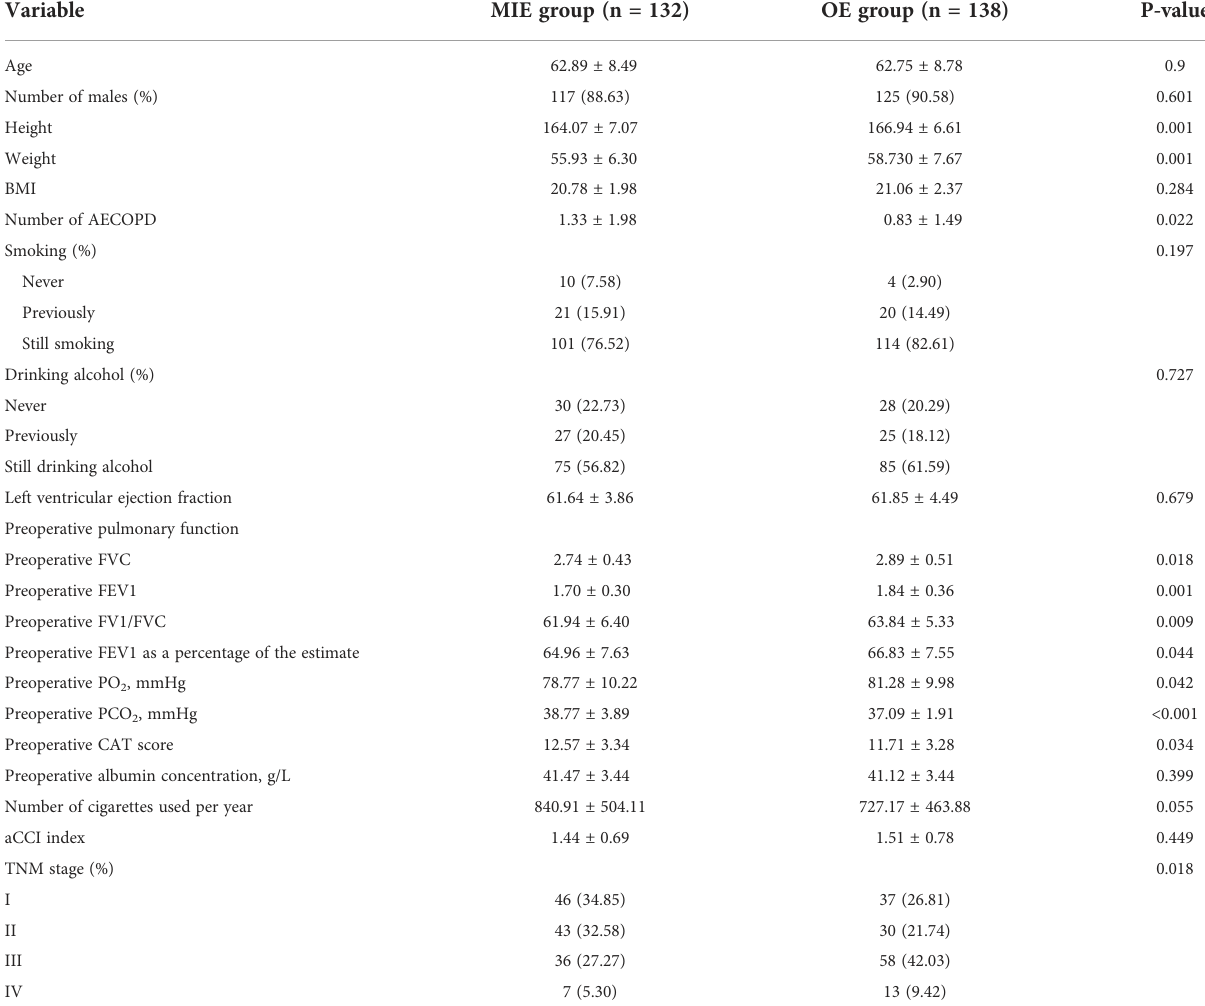
TABLE 1 Baseline data of both groups before propensity score matching